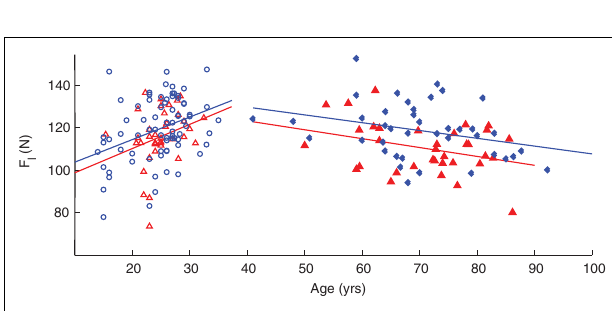
FIGURE 6 | Comparison of rate of decline between clinical and control populations . Finger compression force was plotted against age and revealed that the clinical groups (PD and CMC OA, green circles and blue squares, respectively) had a greater rate of decline with age than control participants (red triangles).